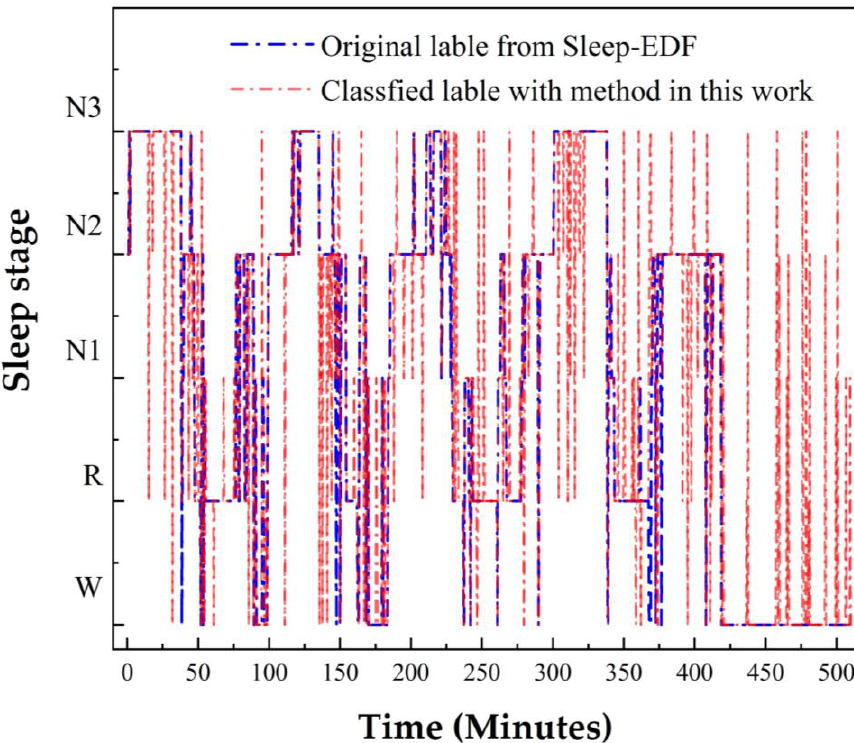
Figure 5. The classification performance was evaluated with the test set of SC4001.